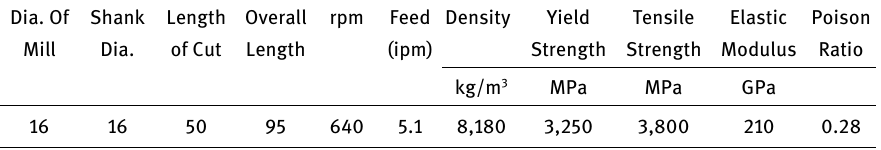
Table 1: Specification super hard end mill four flute list 6210 code 4SE